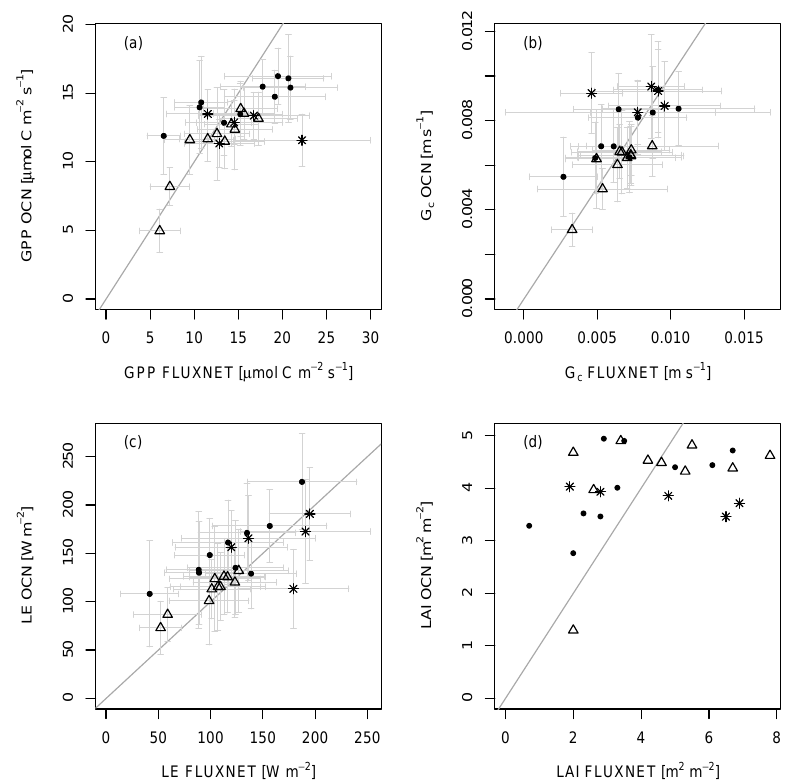
Figure 1. Comparison of measured (a) GPP, (b) canopy conductance ( G c ), (c) latent heat flux (LE), and (d) LAI at 26 European FLUXNET sites and simulations by OCN. Displayed are means and standard deviations of daily means of the measuring/simulation period, with the exception of FLUXNET-derived LAI, which is based on point measurements. Dots symbolise sites dominated by broadleaved trees, triangles sites dominated by needle-leaved trees, and asterisks sites dominated by C 3 grasses. The grey line constitutes the 1 : 1 line.